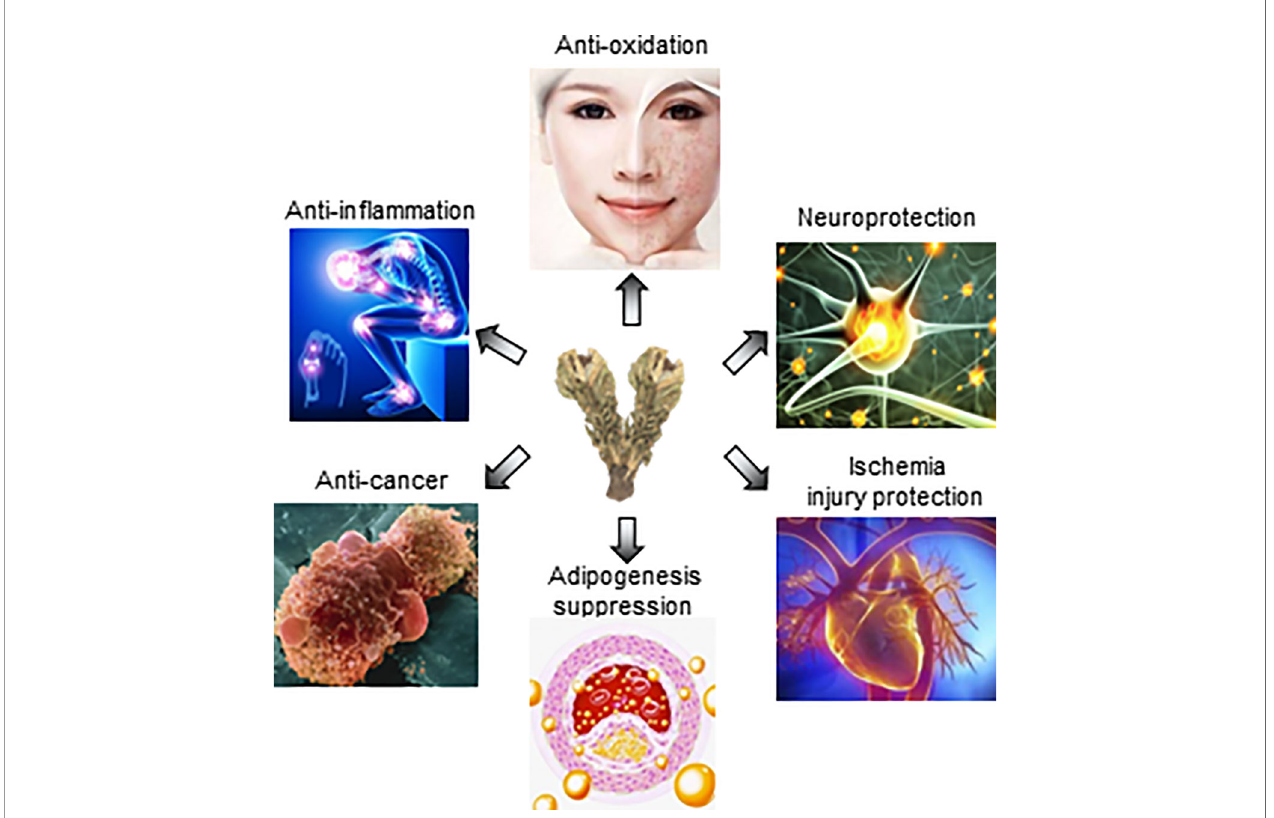
FIGURE 2 | The pharmaceutical values of Snow lotus. Saussureae Involucratae Herba possesses anti-oxidative functions, neuroprotective effects, anti-in fl ammatory- induced diseases, anti-cancer, anti-obesity and ischemia injury protective pharmaceutical